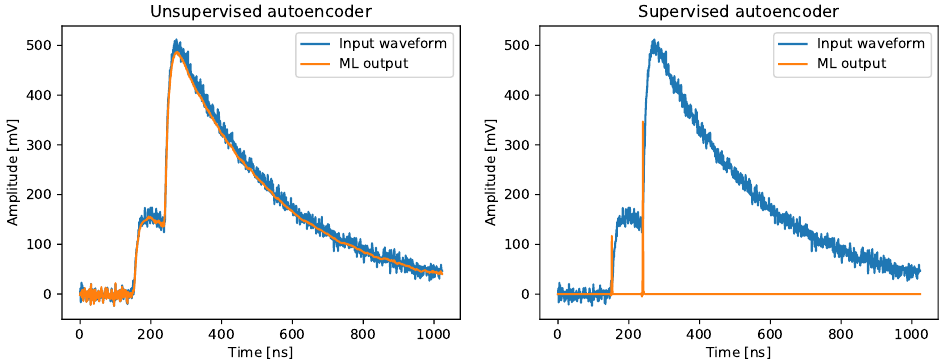
Figure 4. Autoencoder NN output and the original event with two signals. ( Left ) classical autoen- coder. ( Right ) modified